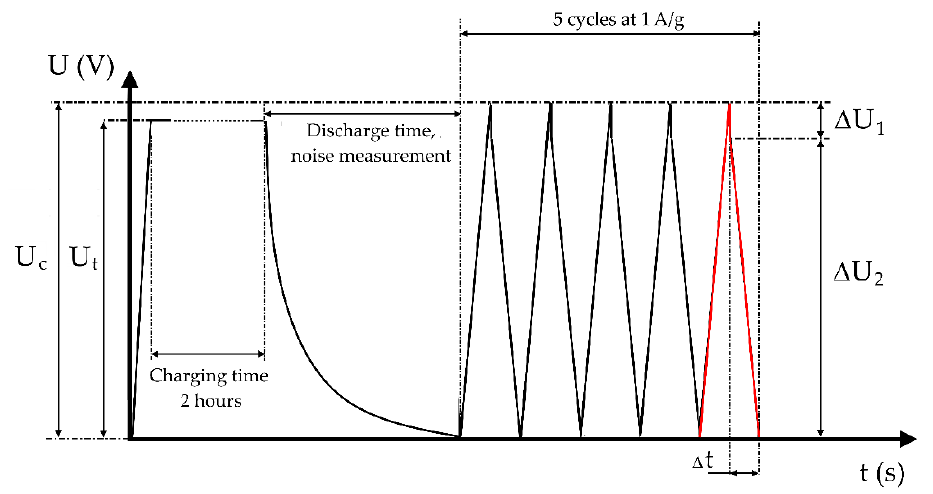
Figure 5. The applied way of determining values of capacitance C and resistance R ESR after noise measurements.